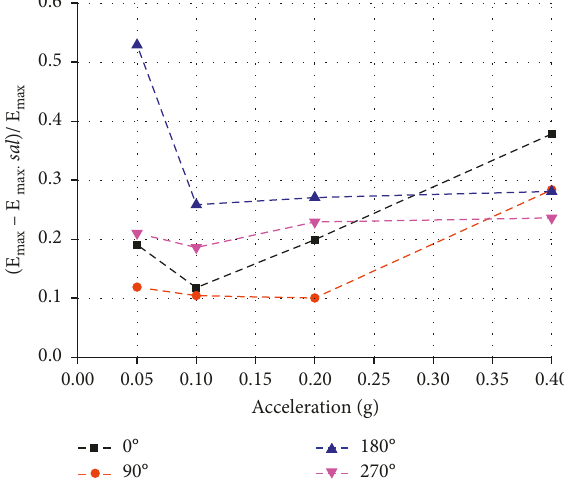
Figure 22: The SAL reduction